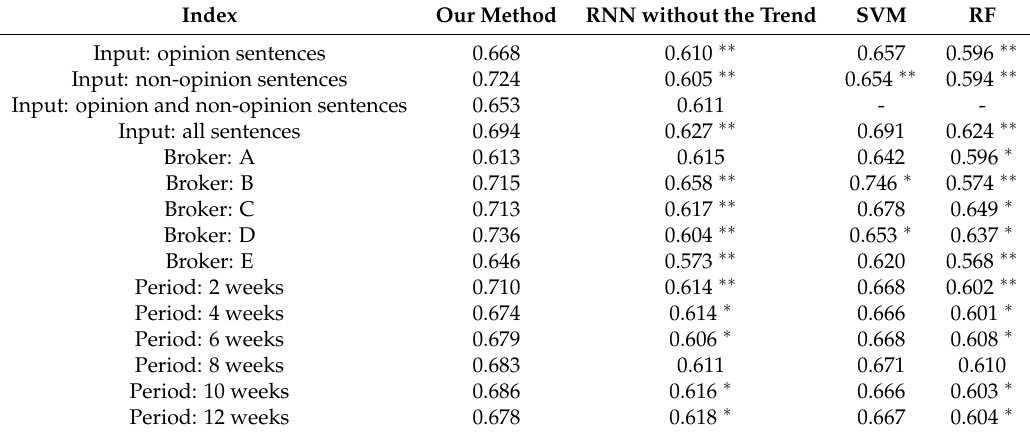
Table 5. Summary of forecasting movements of analyst net income estimates. Macro-F1 is a measure. The scores of SVM and RF in the row of input: opinion and non-opinion sentences are indicated by hyphens (-) because SVM and RF cannot have inputs of opinion and non-opinion sentences separately.